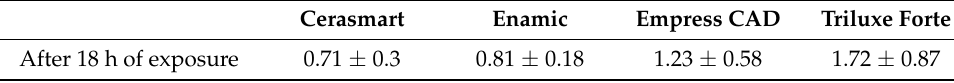
Table 2. Color change ( ∆ E ) calculated after gastric acid exposure ± standard deviation.